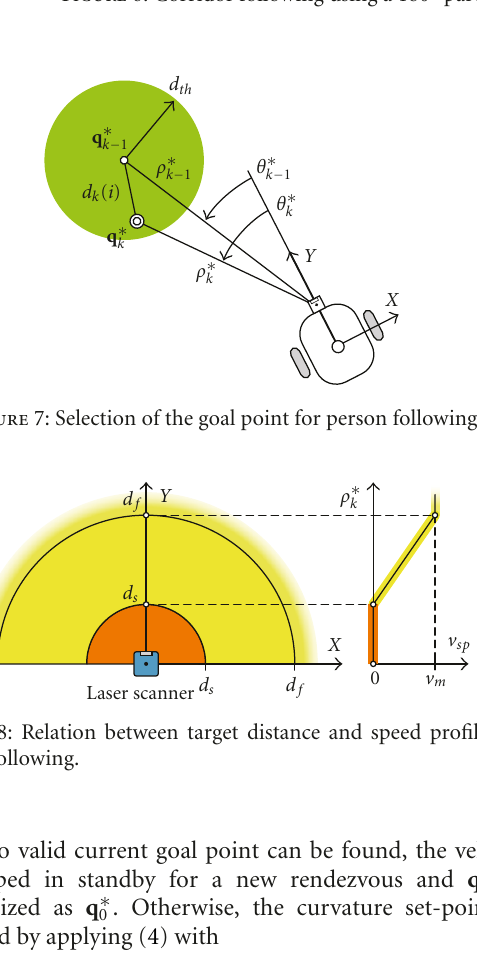
Figure 6: Corridor following using a 180 ◦ partial field of view scanner, when (a) θ r